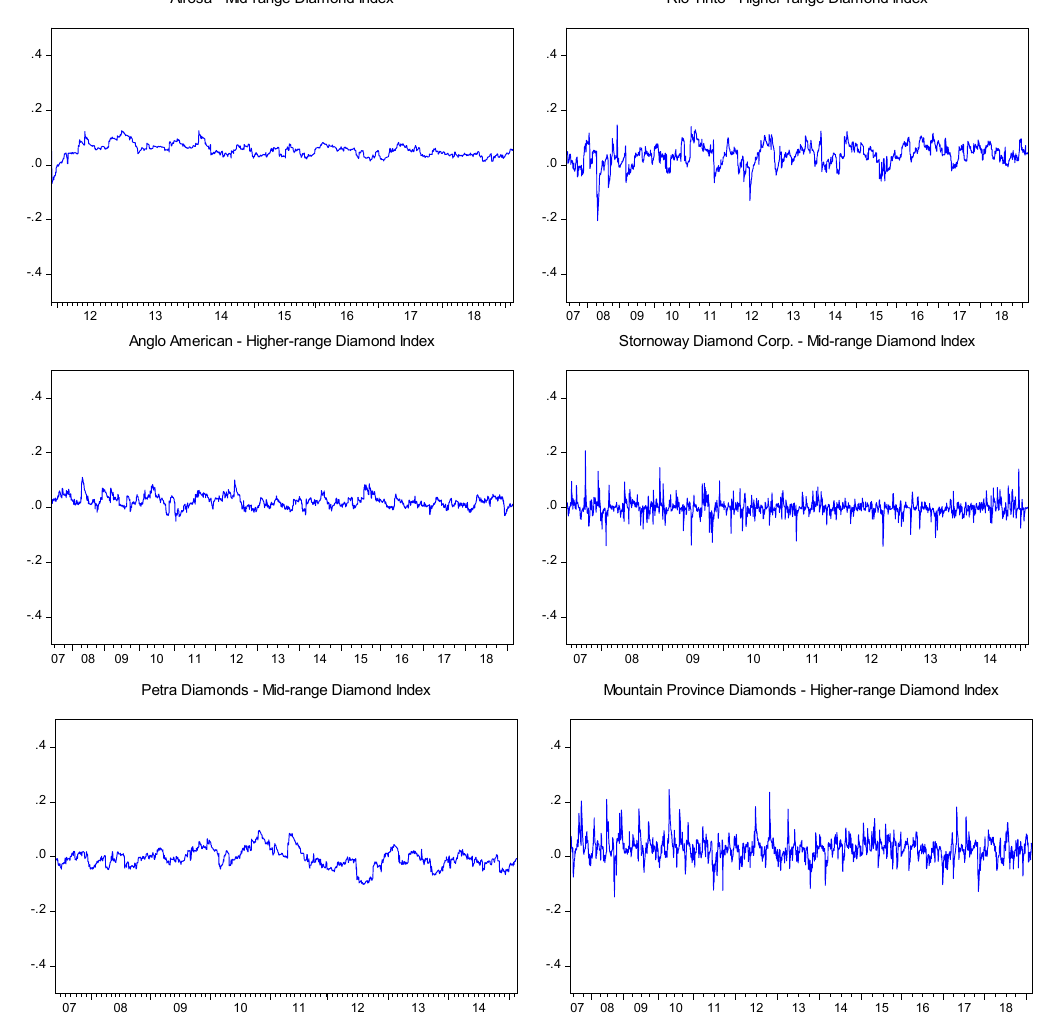
Figure 8. DCC-E-GARCH correlations among diamond stocks and diamond indices. Notes: The figure presents some of the estimated time-varying correlations (DCC-E-GARCHs) between log returns of studied diamond stocks and 2 diamond indices: (Alrosa - Mid-range DI, Rio Tinto - Higher-range DI, Anglo American – Higher-range DI, Stornoway Diamond Corporation – Mid-range DI, Petra Diamonds – Mid-range DI and Mountain Province Diamonds – Higher-range DI) for the period 4 June 2007–15 February 2019. Source : Elaboration on Bloomberg and Yahoo Finance data . Table 9. DCC parameters from the DCC-EGARCH correlation estimations.